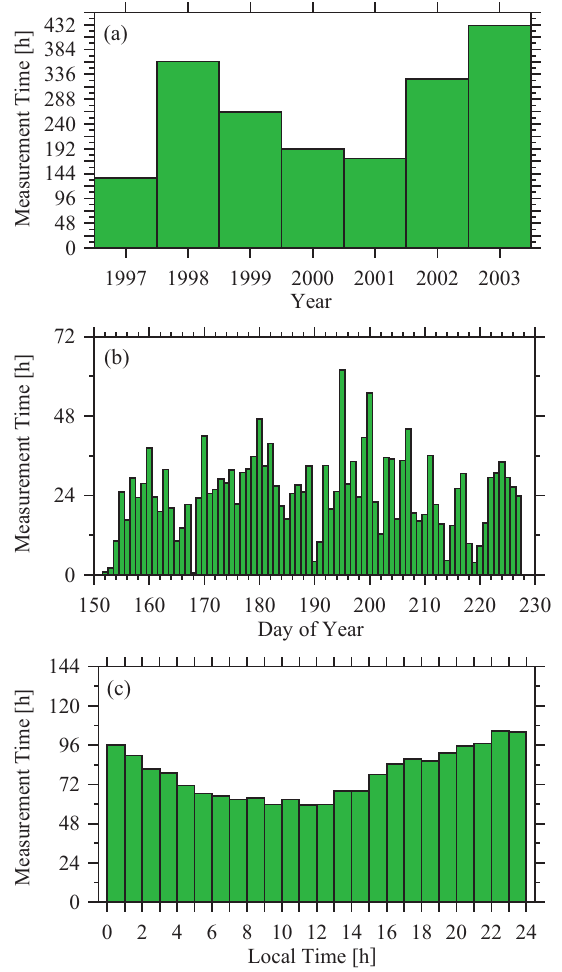
Fig. 1. Time distribution of the ALOMAR RMR lidar total mea- surements as a function of years ( a ) , season ( b ) , and day ( c ) be- tween 1 June and 15 August from 1997 to 2003.